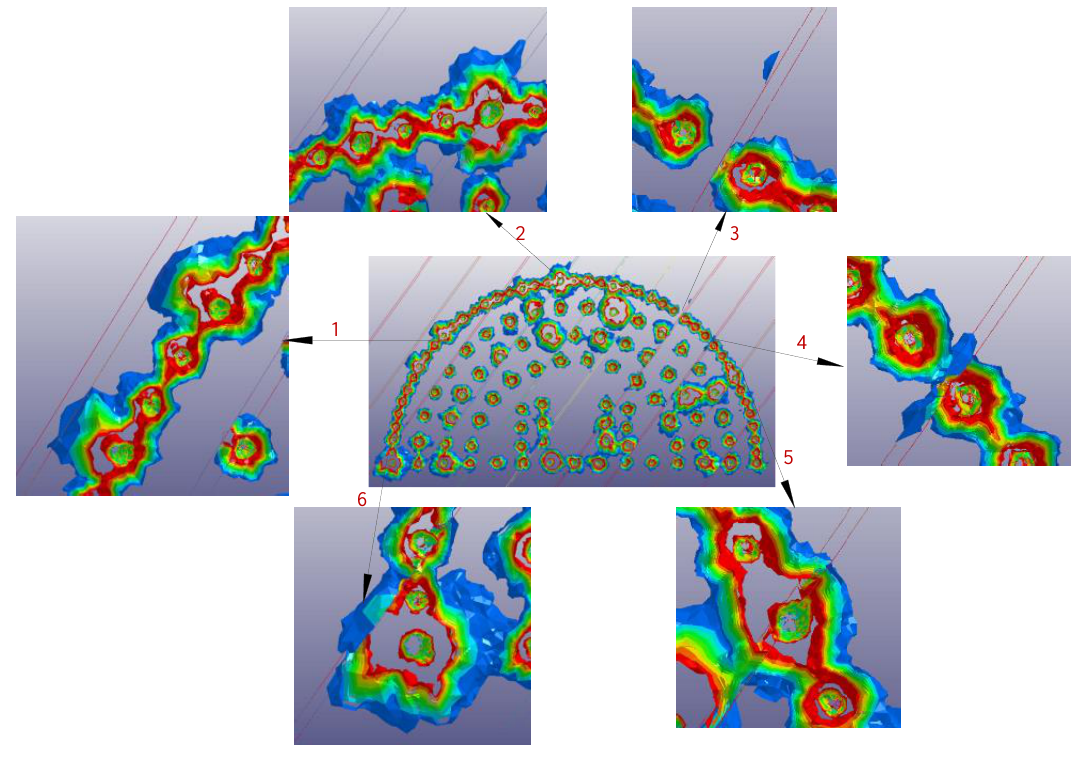
Figure 12. Damage contour of smooth blasting tunnel in the numerical study.